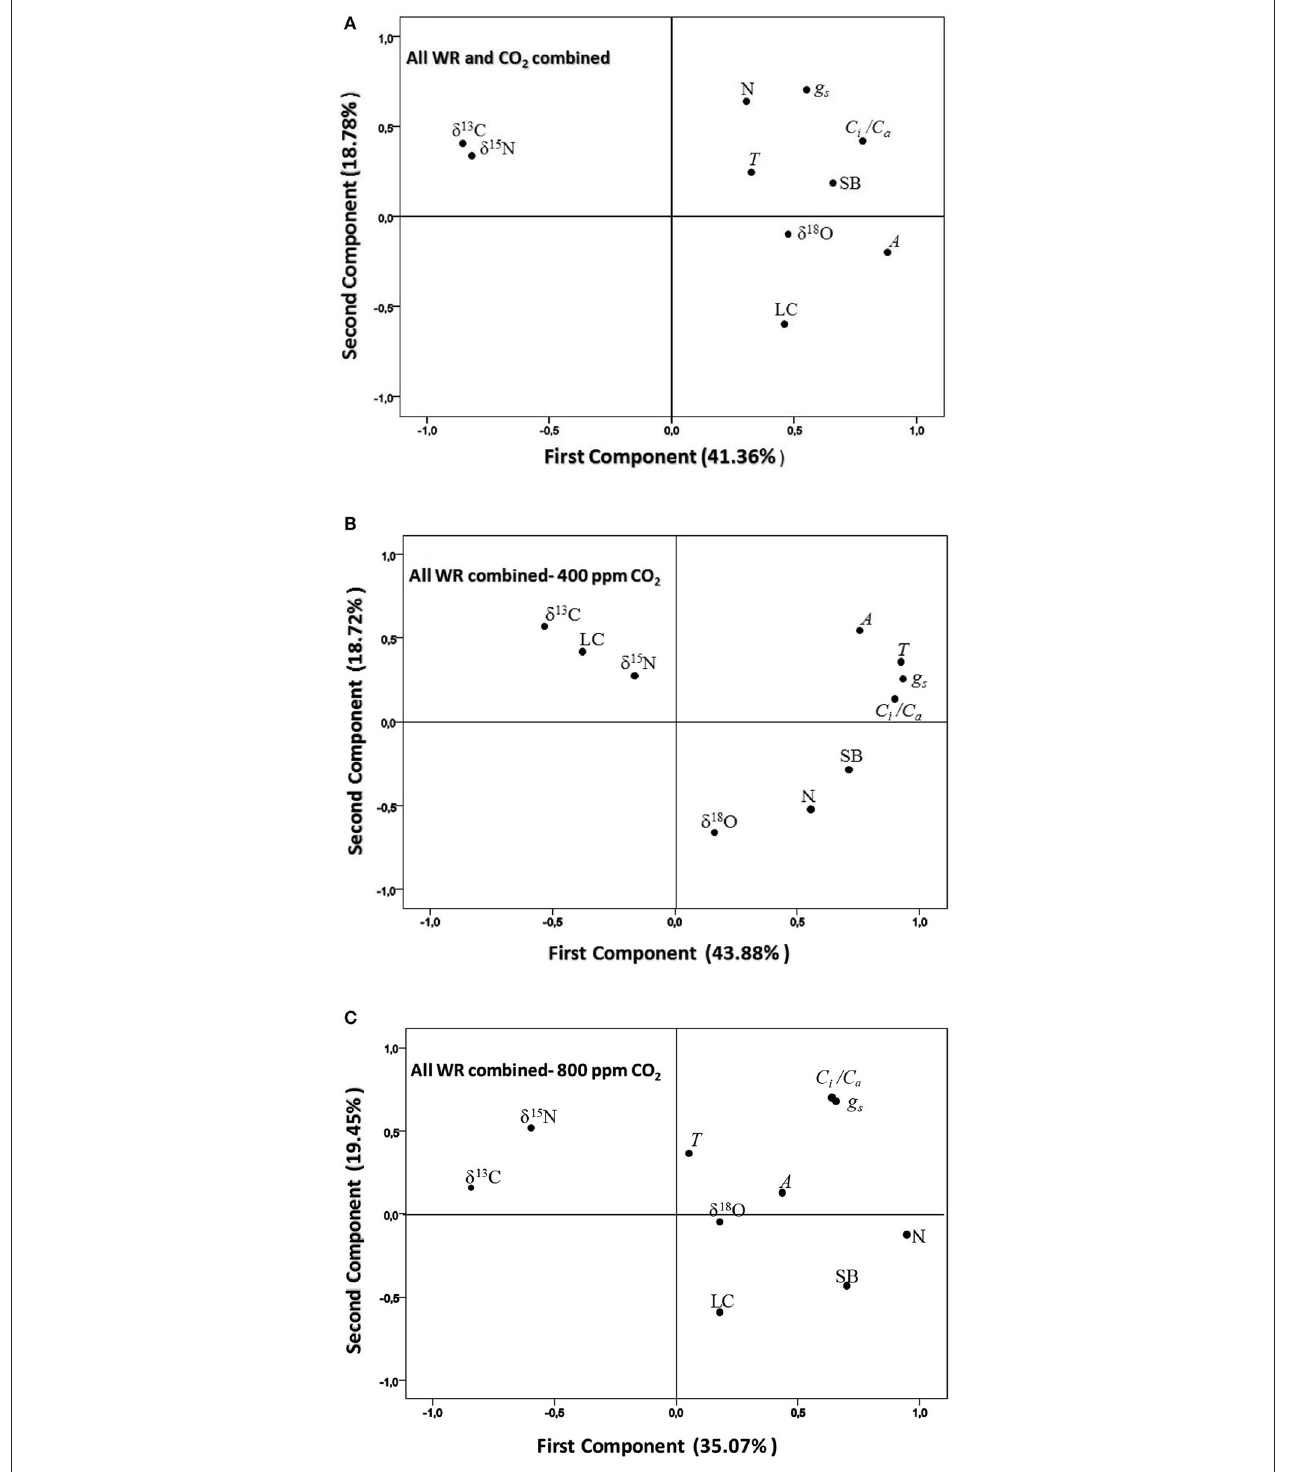
FIGURE 3 | Principal component analysis of shoot biomass (SB) and different physiological traits related to the photosynthetic, transpirative, and nitrogen status of the plant were set for four sweet pepper varieties grown under (A) three different water regimes (WR) and two [CO 2 ] combined, (B) , three water regimes at atmospheric [CO 2 ], and (C) three water regimes at high [CO 2 ]. The physiological traits included as variables are: the stable carbon, oxygen and nitrogen isotope compositions ( δ 13 C, δ 18 O, δ 15 N), the nitrogen concentration (N), the chlorophyll content (LC), and the net CO 2 Assimilation (A), transpiration (T), stomatal conductance (g s ), and the ratio of the intercellular vs. the atmospheric [CO 2 ] (C i /C a ) of leaves.